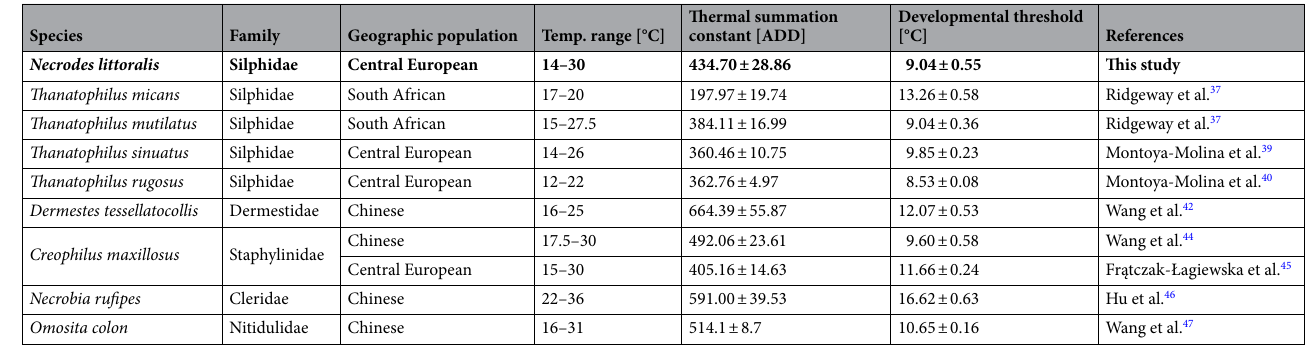
Table 4. Comparison of thermal summation models for the eclosion created for forensically important